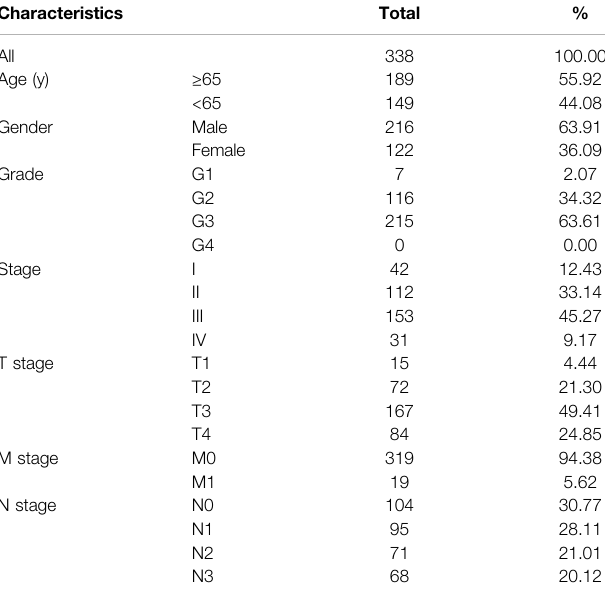
TABLE 1 | Clinical characteristics of STAD patients in the TCGA